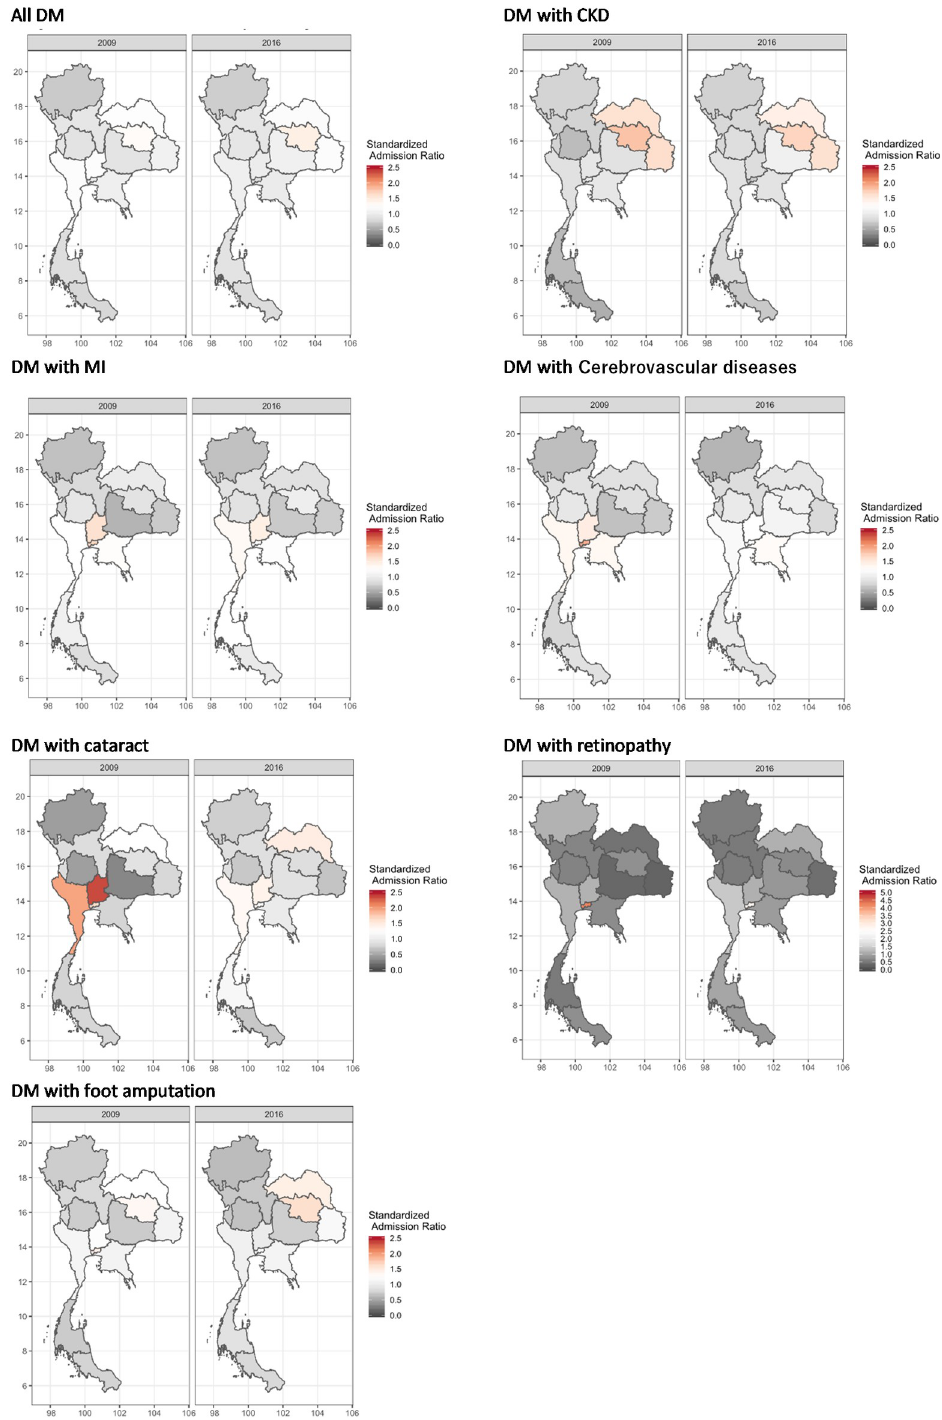
Fig 5. Comparison of age- and sex- standardized admission rate of type 2 diabetes mellitus and its complications in the NHSO Regions in 2009 and 2016. Note: The standardized admission rate (SAR) of type 2 diabetes mellitus (T2DM) and its complications were shown in white if it is the national average. The color changes into red if SAR is higher than the national average, and gray if it is lower than the national average. The scale for SARs of T2DM with retinopathy is different from others: it continues up to 5.0 because SAR of T2DM with retinopathy in Bangkok was substantially higher than other regions in 2009.